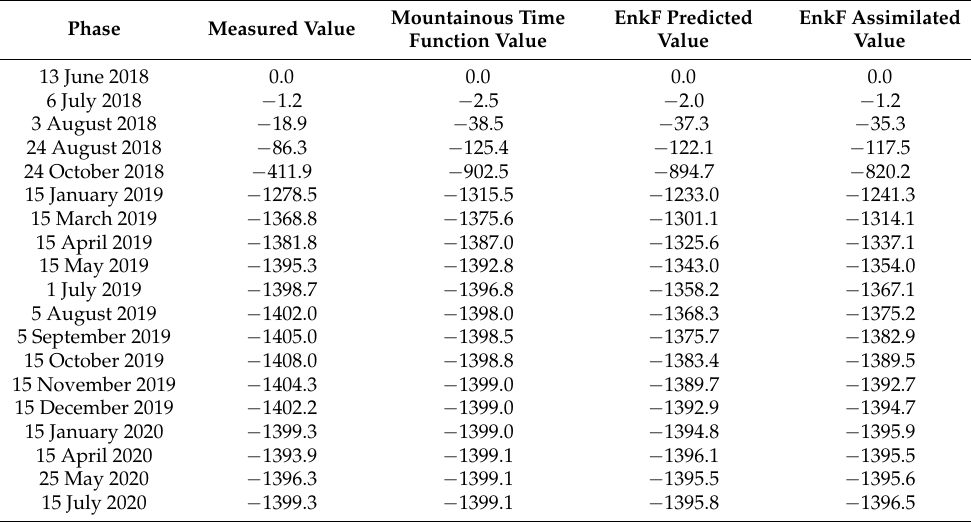
Table A3. The subsidence values of the observation point A28 acquired by different methods (mm).